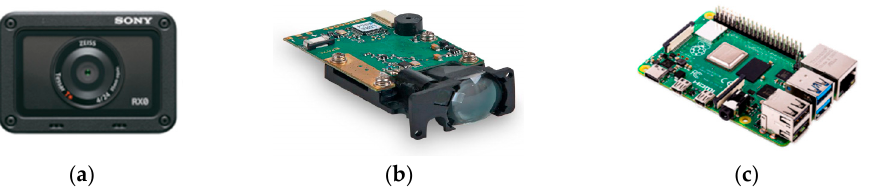
Figure 4. Hardware used in the integrated design [24–26]. ( a ) Camera ( b )Laser ranging module ( c ) Raspberry Pi 4.